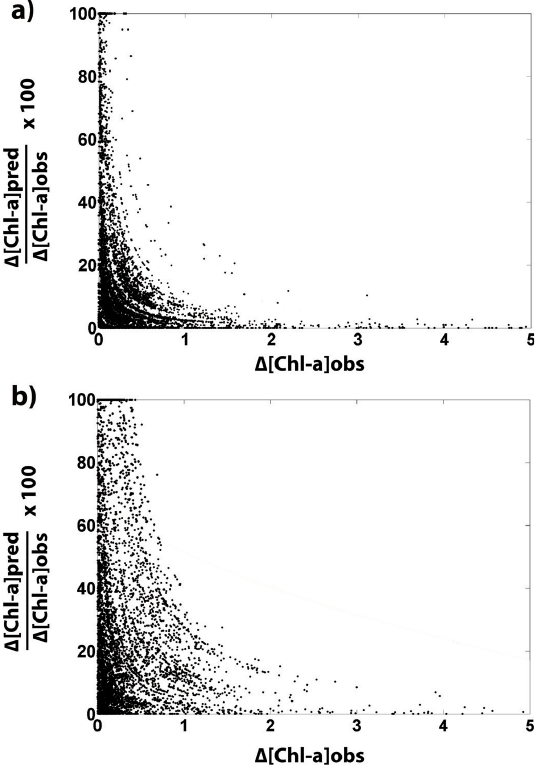
Fig. 10. Percent ratio of 1 [Chl- a ] pred / 1 [Chl- a ] obs for the grid cells with positive values of remotely-sensed 8-day averaged [Chl- a ] dif- ferences (after the storm minus before) for the (a) J23 and (b) F11 dust episodes. Black dots depict the grid cells located in the HNLC regions of the